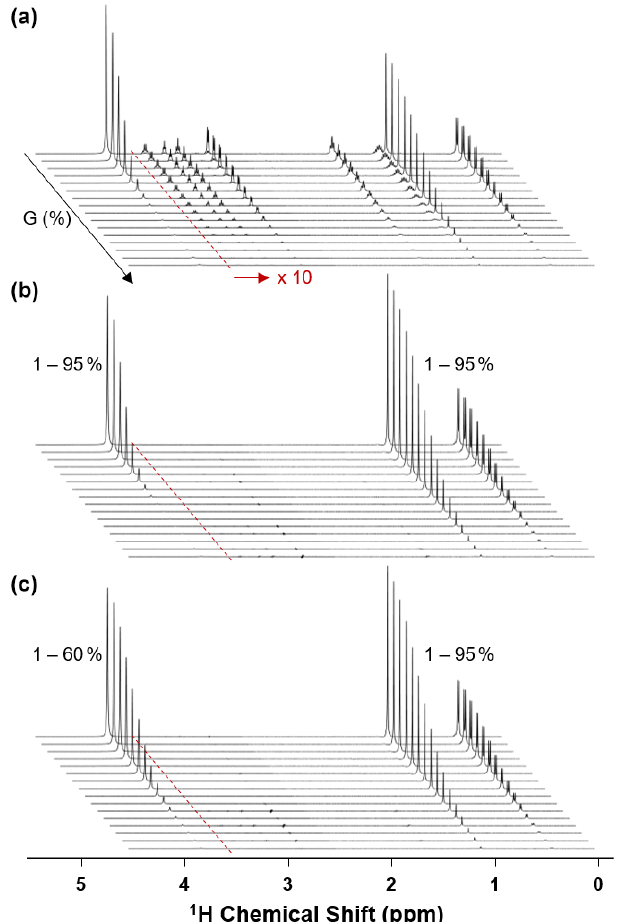
Figure 2. Exemplary 1 H NMR spectra of 20mgmL − 1 Met-Ala- Ser (MAS) tripeptide non-selective (a) and selective (b, c) diffusion experiments. The resonances used for selective encoding were wa- ter (4.8ppm), the Met methyl group of MAS (2.1ppm), and the Ala methyl group of MAS (1.5ppm). As demonstrated in panel (c) , us- ing selective encoding, the gradient amplitude experienced by the water signal could be controlled independent of that experienced by the MAS signals (1%–60% vs. 1%–95%). In all plots, the inten- sity of the region from 1–4.5ppm was increased by a factor of 10 for clarity (highlighted in panel a